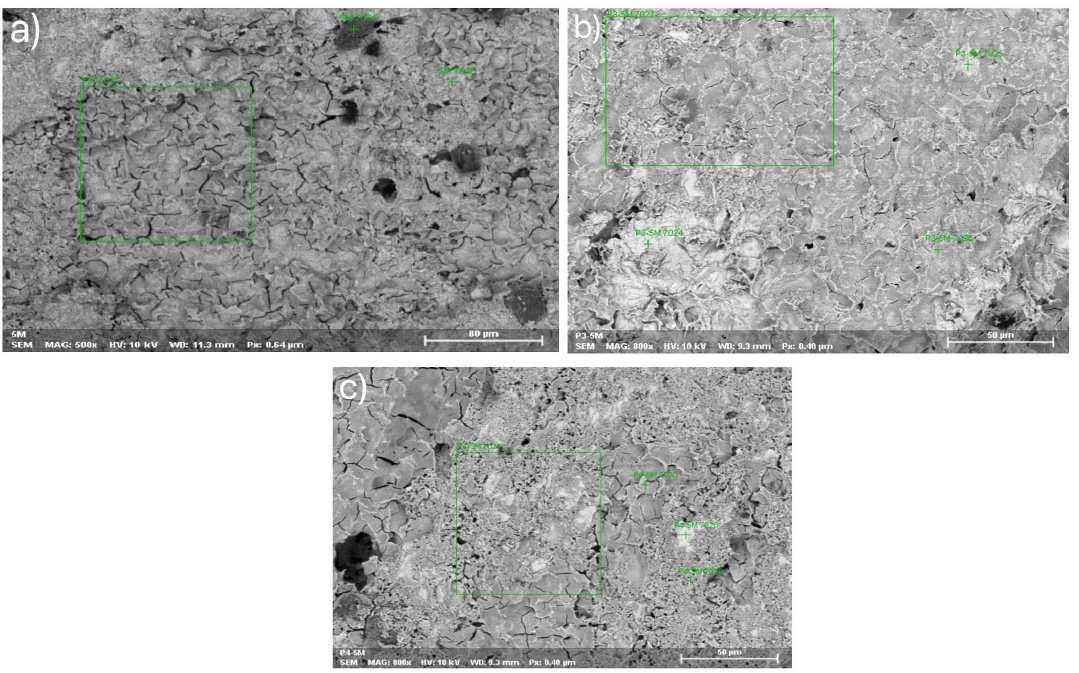
Figure 11. SEM micrograph for ordinary mild steel surface after 24 h of immersion in 5.0 M HCl solution (a) blank solution, (b) with the presence of 10-3 M of P3 and (c) with the presence of 10-3 M of